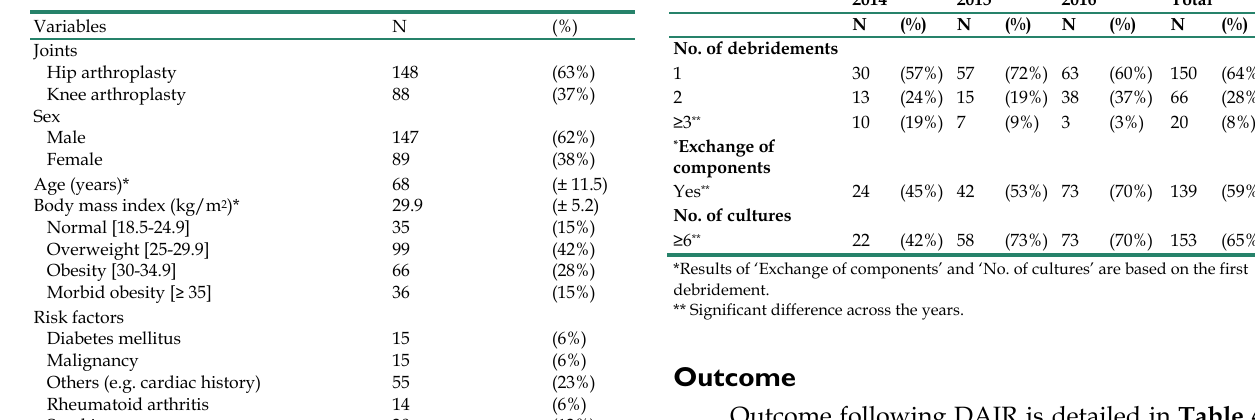
Table 1. Patient demographics, baseline clinical characteristics and prosthetic characteristics.